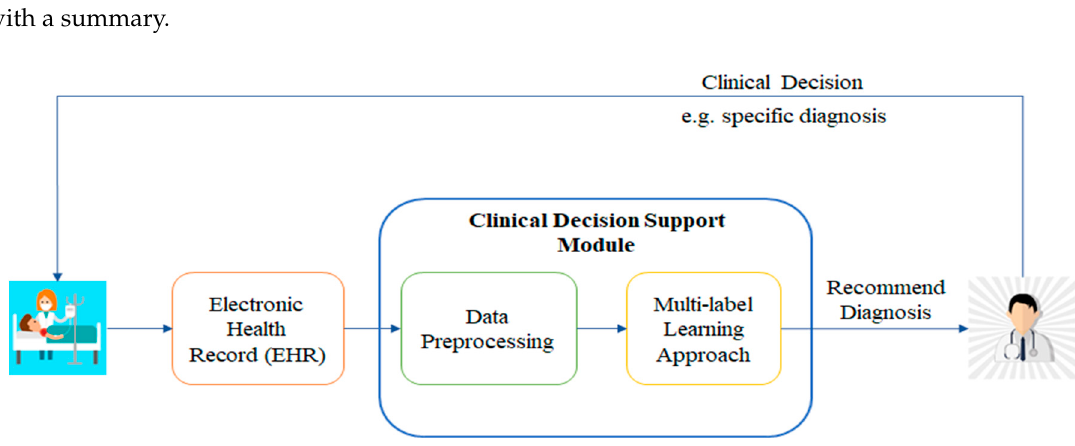
Figure 1. Overview of the decision support system for medical diagnosis.